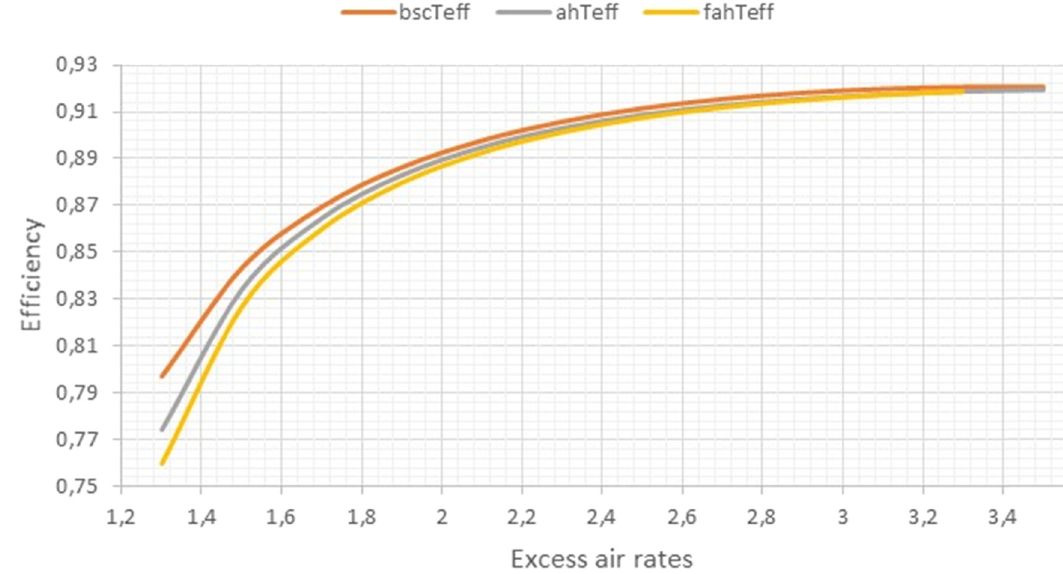
Figure 13: Variation of the turbine e ffi ciency with excess air rates for bsc, ah and fah cogeneration plants.